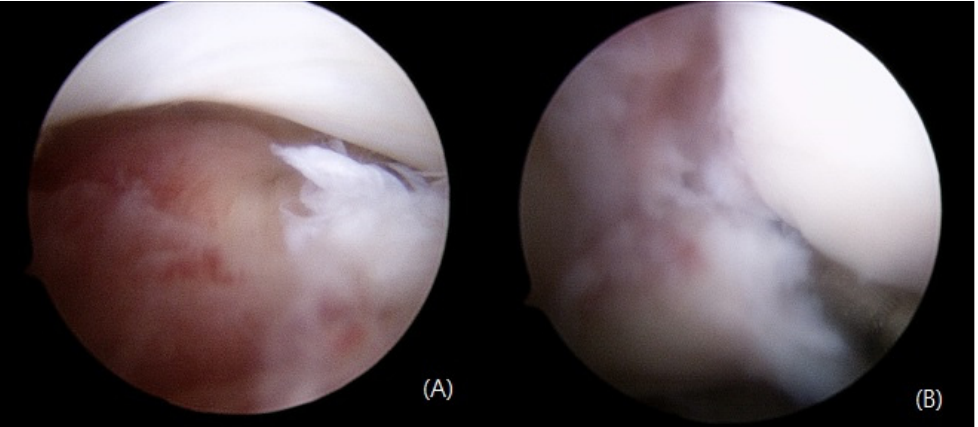
Figure 4. Intraoperative arthroscopic findings of syndesmotic injury with widening of the gap between the fibula and tibia ( A ), and posterior inferior tibiofibular ligament rupture at the point of tibial insertion ( B ).